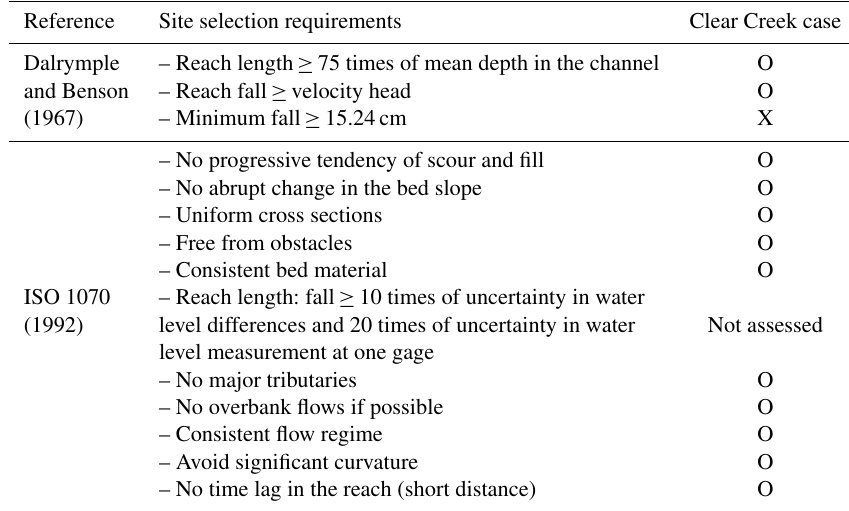
Table 1. Requirements for the selection of slope area channel reaches.